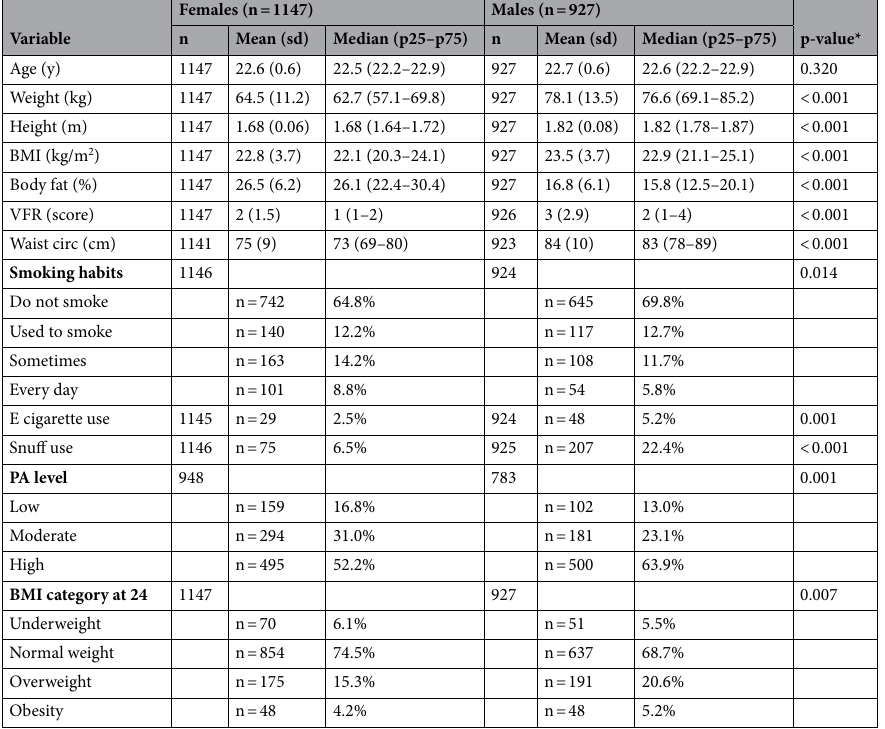
Table 1. Descriptive characteristics of the study population (n = 2074). *Mann–Whithney U-test or Chi 2